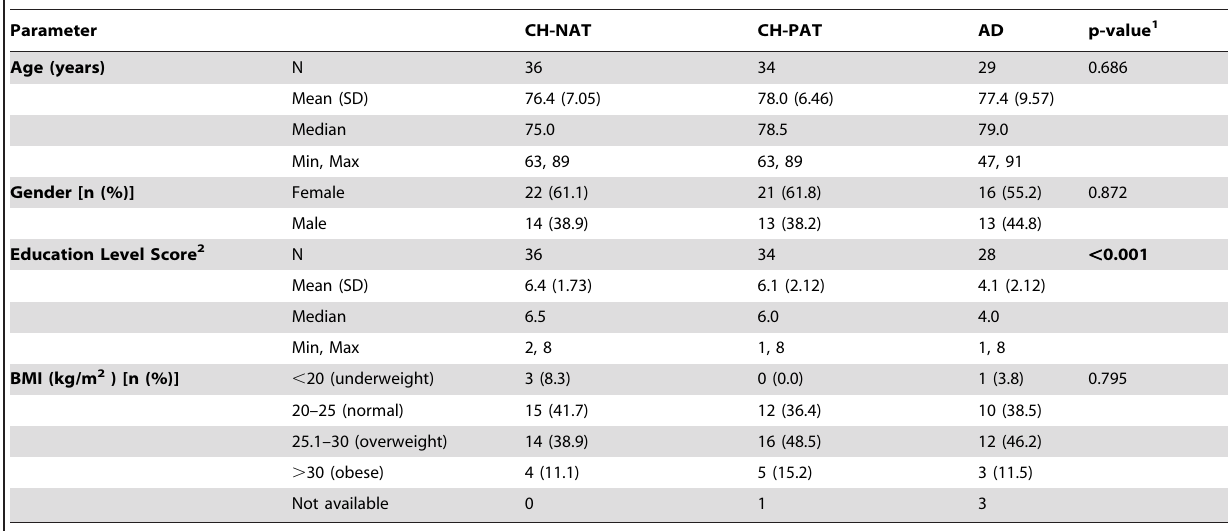
Table 1. Demographics by clinical group.